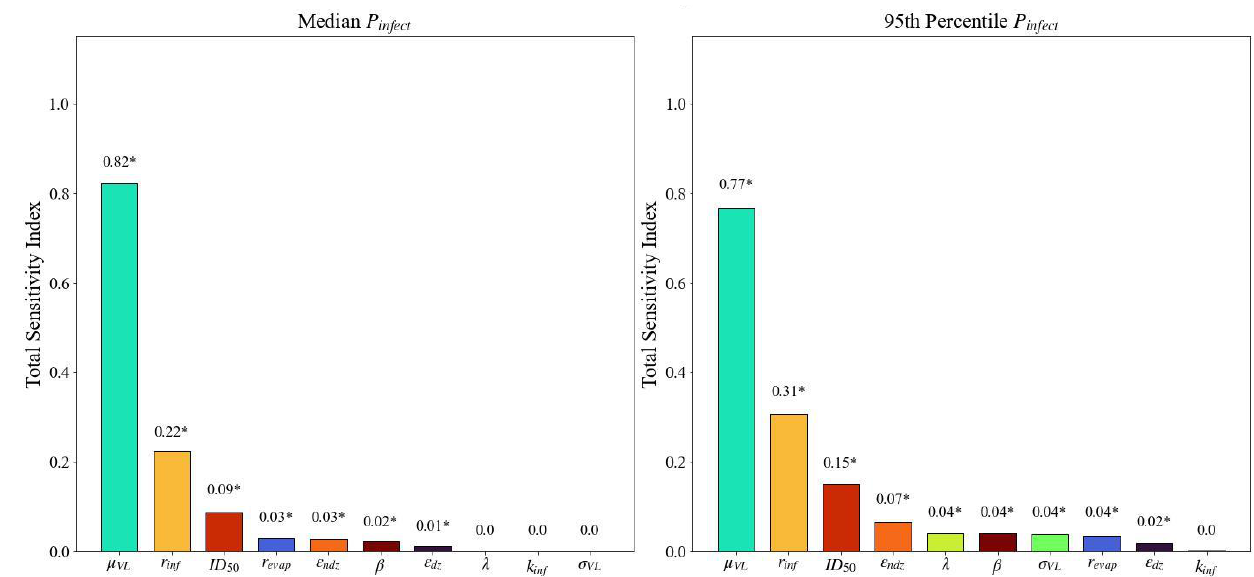
Figure 10. Total sensitivity indices (ordered from largest to smallest) derived using eFAST for the median P infect and 95th percentile of P infect with breathing as the emission mechanism. Asterisks (*) indicate statistically significant sensitivity indices ( α = 0.01).